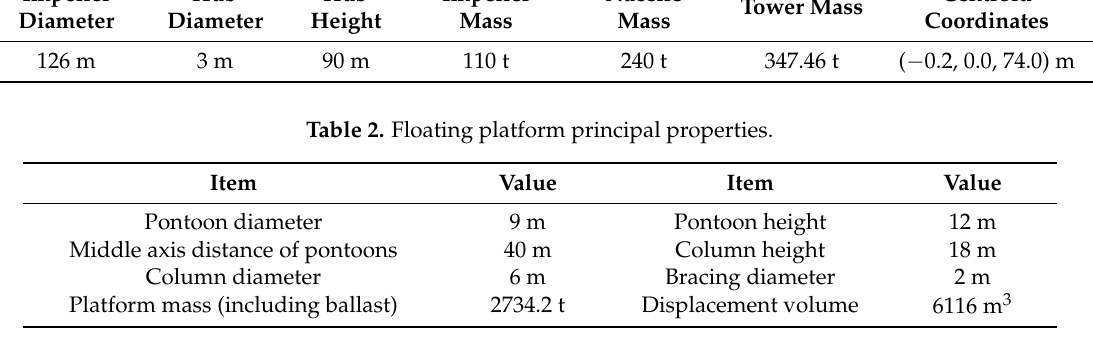
Table 3. Mooring system principal properties.